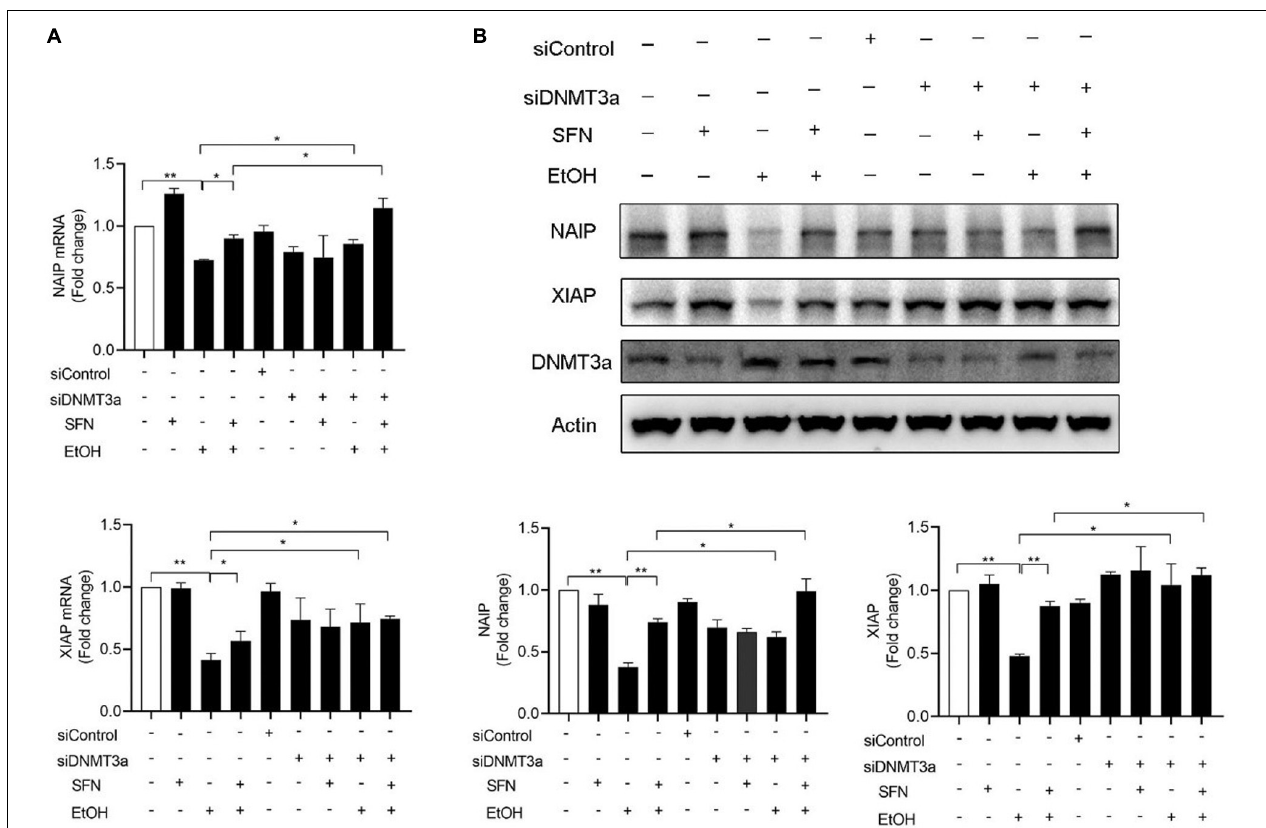
FIGURE 5 | The knockdown of DNMT3a diminished ethanol-induced down-regulation of NAIP and XIAP and enhanced the effects of SFN against ethanol-induced down-regulation of NAIP and XIAP in hNCCs. hNCCs transfected with control-siRNA or DNMT3a-siRNA were treated with 1 µ M SFN for 24 h, followed by concurrent exposure to 1 µ M SFN and 50 mM ethanol for an additional 24 h. (A) The mRNA expression of NAIP and XIAP was determined by qRT-PCR. (B) The protein expression of NAIP and XIAP was determined by Western blotting. Data are expressed as fold change over control and represent the mean ± SEM of three separated experiments. * p < 0.05, ** p <